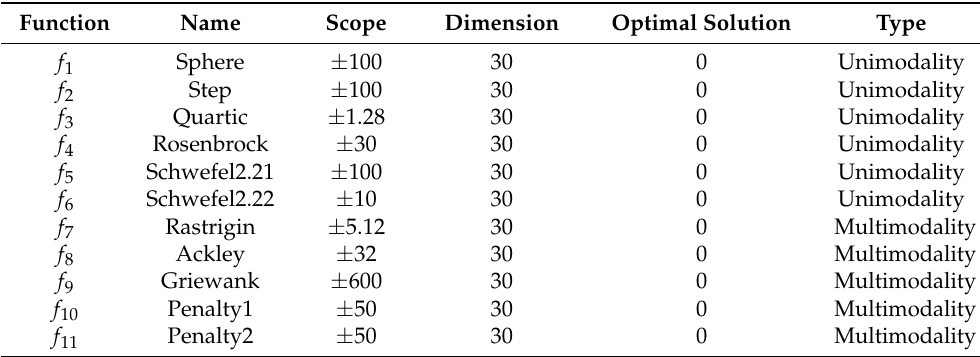
Table 2. Test performance function